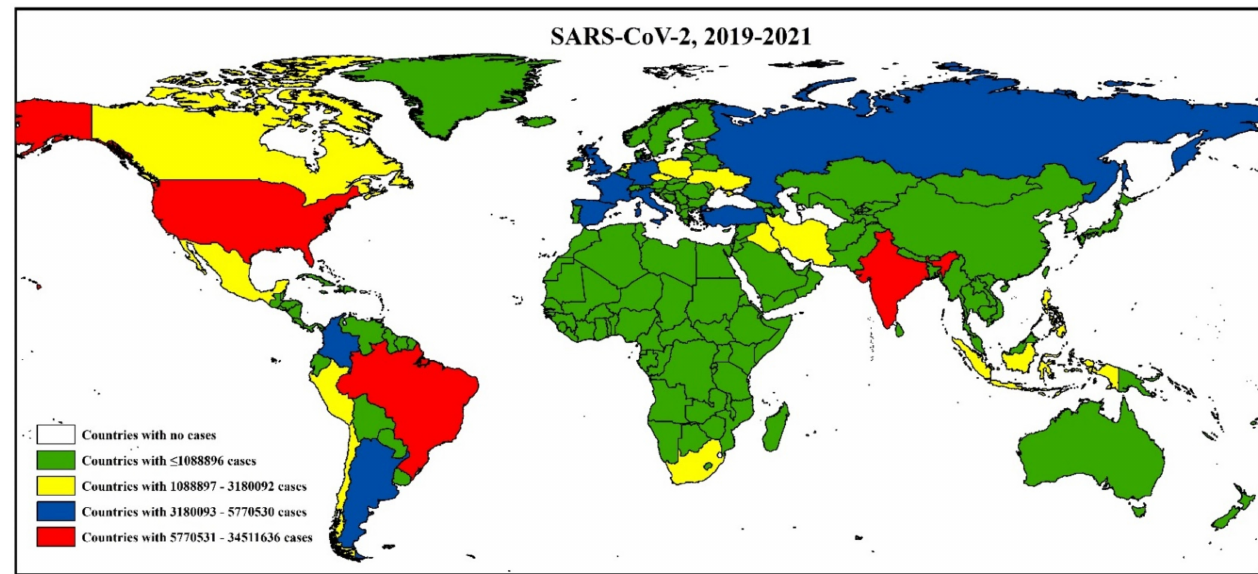
Figure 8. Distribution of SARS-CoV-2 cases around the world. The white areas have no cases, whereas the red marked regions have the highest number of